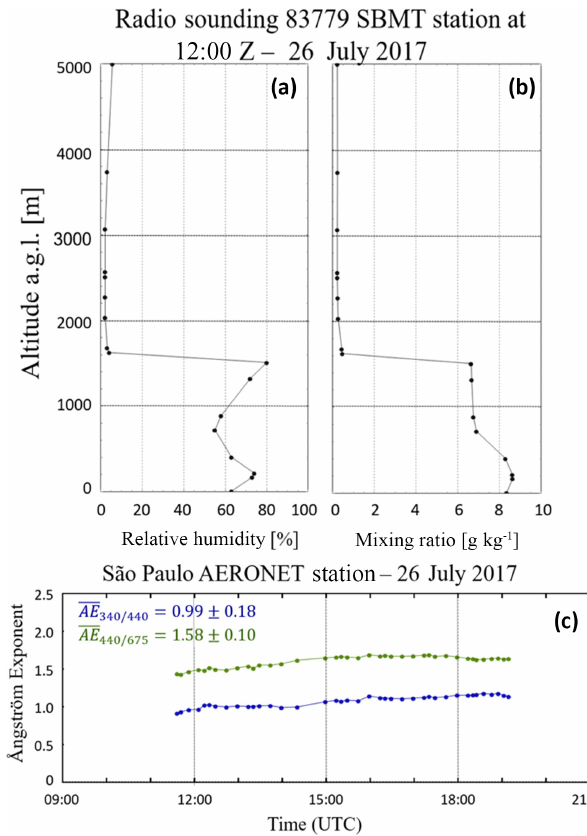
Figure 3. (a) Vertical profile of relative humidity derived from radio sounding. (b) Mixing ratio derived from radio sounding. (c) Aerosol-optical-depth-related Ångström exponent time series from AERONET, for measurements retrieved at 26 July 2017.